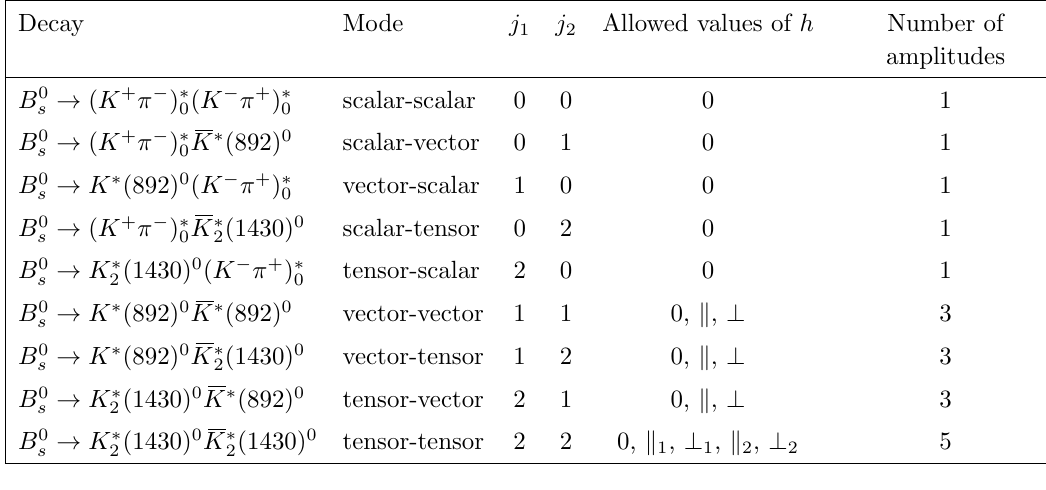
Table 1 . Quasi-two-body decay channels and corresponding polarisation amplitudes contributing to the B 0 ( K + (cid:25) (cid:0) )( K (cid:0) (cid:25) + ) (cid:12)nal state in the K(cid:25) mass window from 750 to 1600 MeV =c 2 . s !